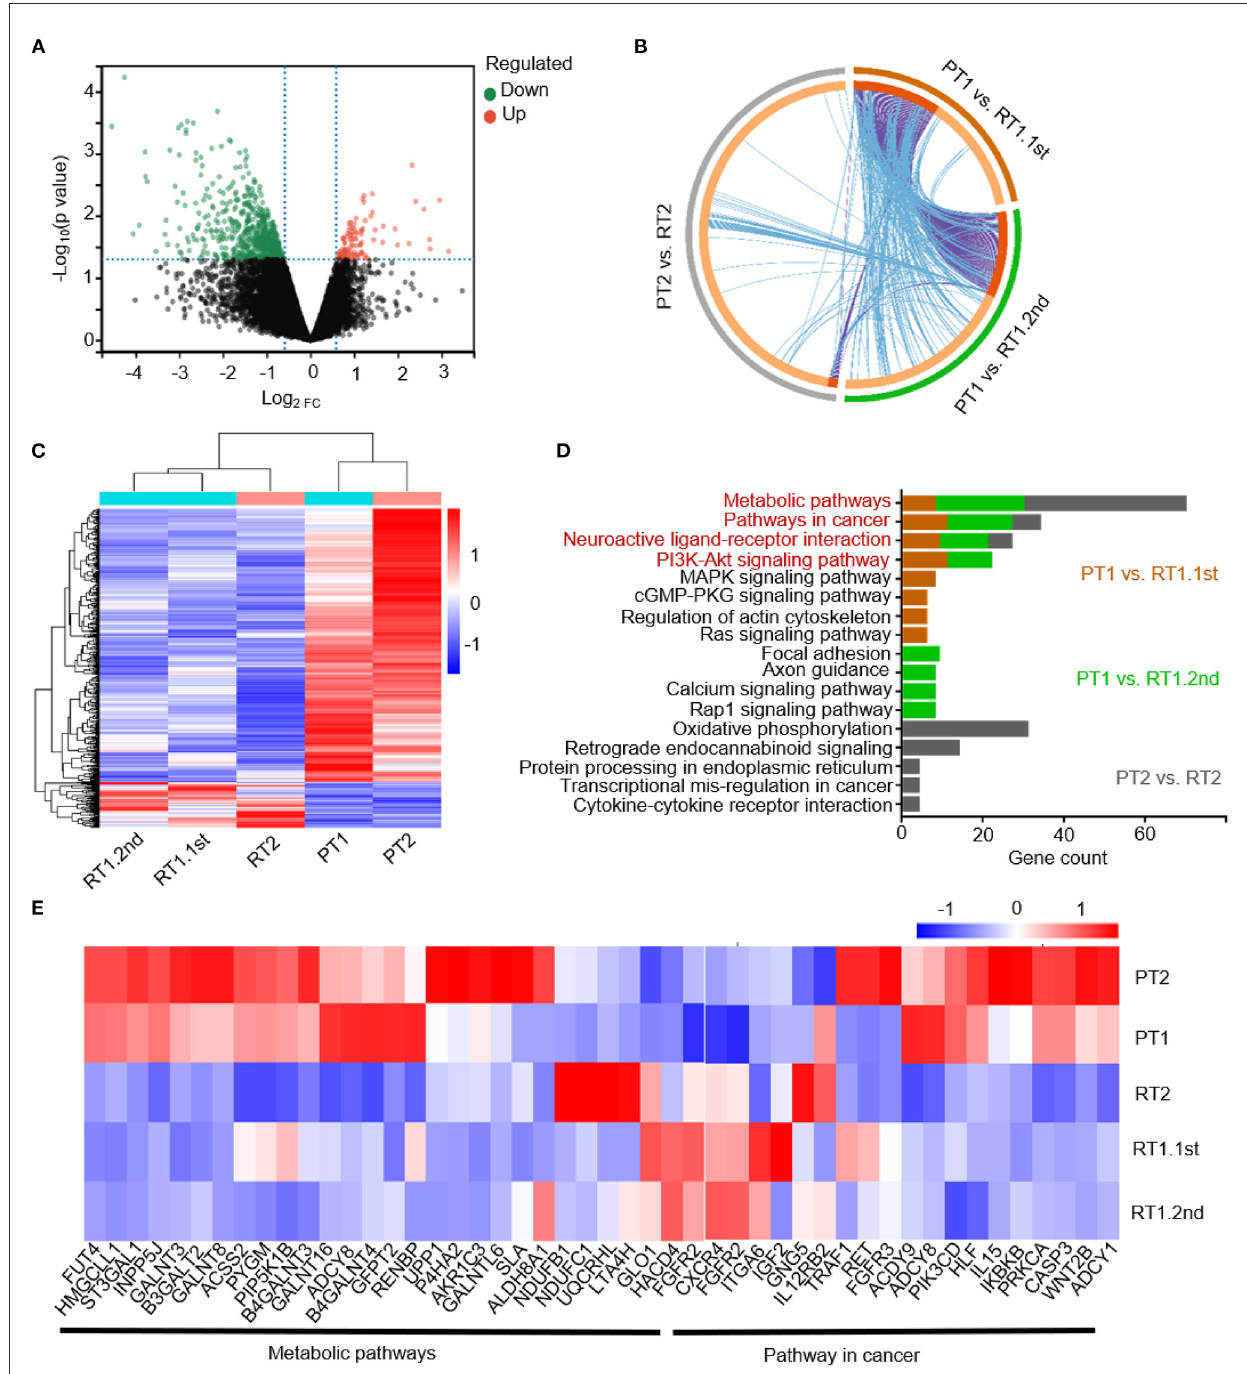
FIGURE2 Transcriptional profiles of the primary and matched sub-frontal recurrent MBs. (A) The volcano plot showed gene expression changes in sub-frontal recurrent tumors. Upregulated genes were in red, and downregulated genes were in green. (B) Three DEGs lists showed a paucity of overlap of DEGs between each and every matched primary and sub-frontal recurrent tumor. Purple curves linked identical genes and blue curves linked genes that belong to the same enriched pathway term. Genes that hit multiple lists were colored in dark orange, and genes unique to a list were shown in light orange. (C) RNA-seq DEGs expression heatmap of two primary tumors and their three paired recurrent tumors showed significantly differentiated transcriptional profiles. The calculated Z-score scale was shown. (D) KEGG terms for upregulated gene set of recurrent MBs from RNA-seq data showed convergence of metabolic pathway, pathway in cancer, neuroactive ligand–receptor interaction, and PI3K-AKT signaling pathway. (E) Transcript profile of matched primary and sub-frontal recurrent tumors showed differential expression of genes in metabolic pathways and pathways in cancer. The calculated Z-score scale was shown. PT1, primary tumor of case 1; RT1.1st, first sub-frontal recurrent tumor of case 1; RT1.2nd, second sub-frontal recurrent tumor of case 1; PT2, primary tumor of case 2; RT2, sub-frontal recurrent tumor of case